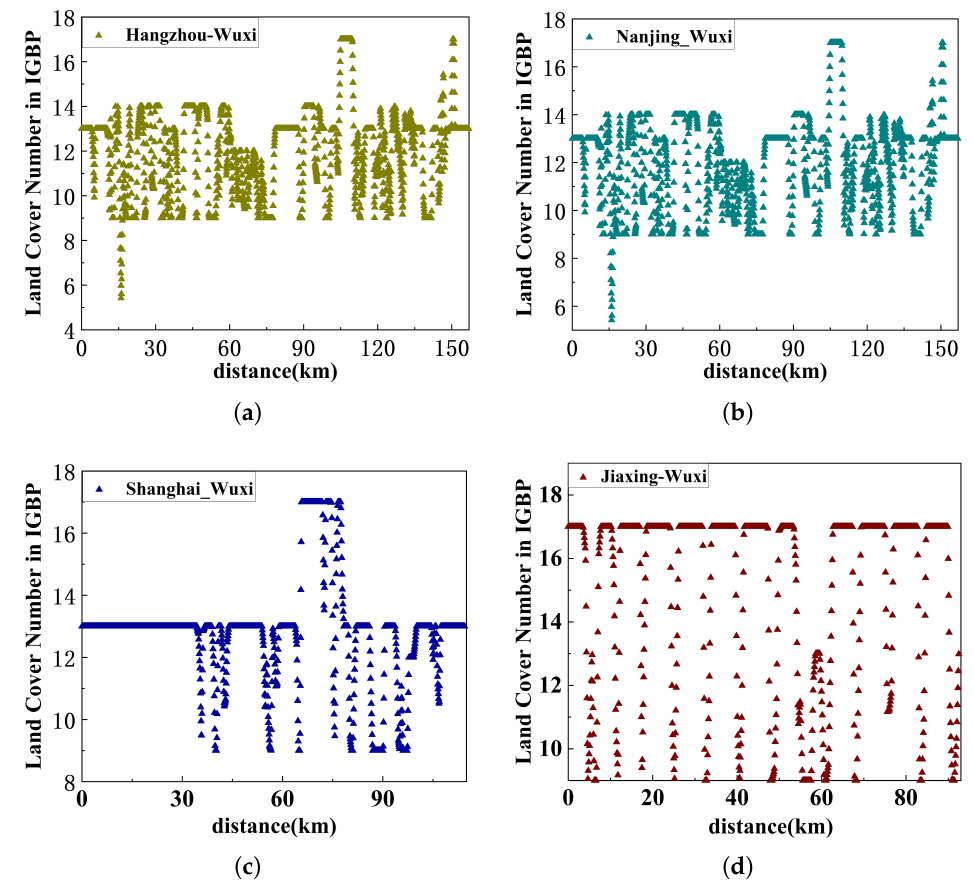
Figure 9. Land Cover types of IGBP on intercity links from four different cities to Wuxi. ( a ) LC distribution on Hangzhou–Wuxi. ( b ) LC distribution on Nanjing–Wuxi. ( c ) LC distribution on Shanghai–Wuxi. ( d ) LC distribution on